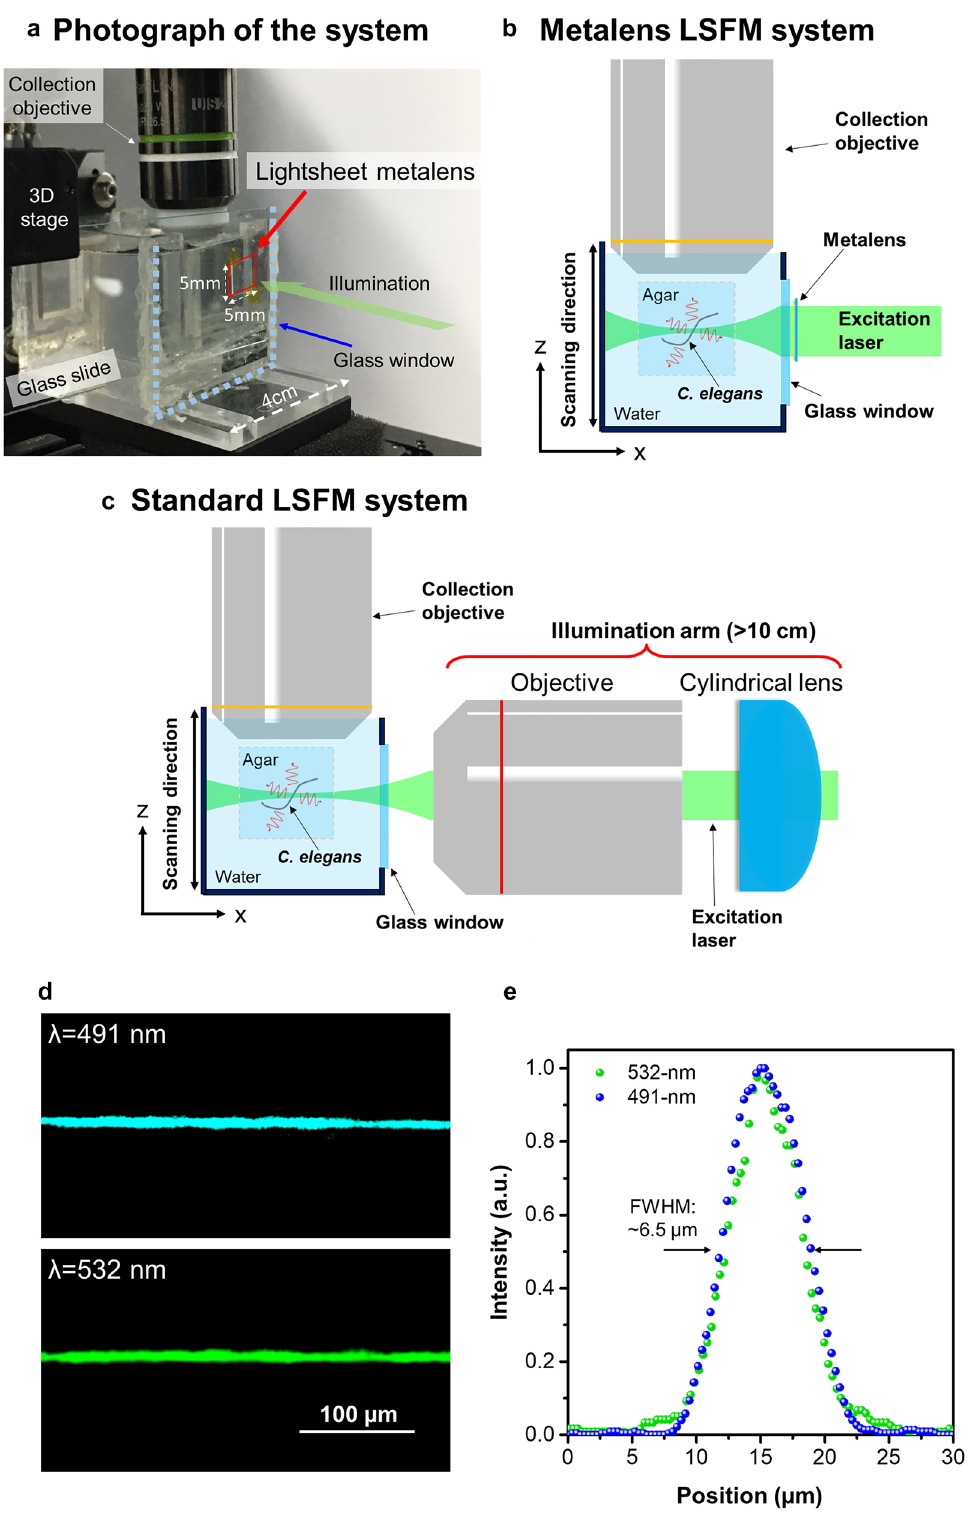
Figure 6: Meta-lens-equipped LSFM. (a) Photograph of the LSFM system. (b) Schematic of the experimental setup for the meta-lens-equipped LSFM. (c) Schematic of the setup for the standard LSFM. (d) Cross-sectional views of the light-sheets generated in water along the y-z plane at 491 nm (top panel) and 532 nm (bottom panel), respectively. (e) Corresponding intensity pro fi les of the respective light-sheet at different wavelengths along the z